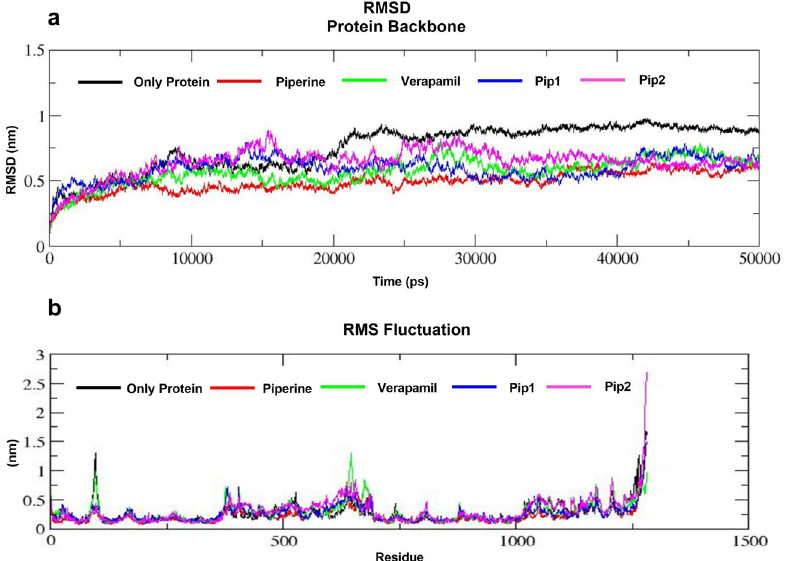
Figure 4. Molecular dynamics (MD) simulation (50 ns) of verapamil, piperine, and piperine analogs (Pip1, Pip2) in complex with the human P-gp model. ( a ) Protein backbone root mean square deviation (RMSD) graph, and ( b ) individual amino acid root mean square fluctuation (RMSF) graph.